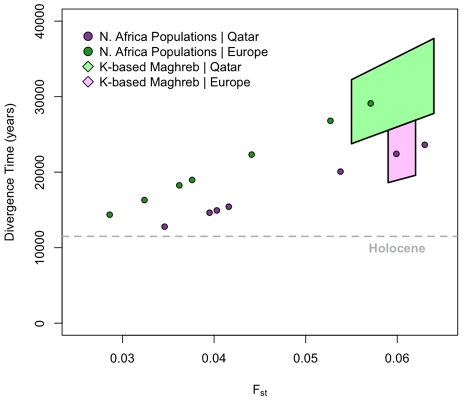
Divergence time estimates among European, Maghrebi, and Near Eastern ancestral populations.We use population-based Fst to estimate divergence time between each of the North African populations and the Qatari (green dots) and Tuscans (purple dots), respectively. We assume point estimates of effective population sizes based on autosomal haplotype heterozygosity estimates from Li et al. [17] (Material and Methods). We further estimate ancestral population clusters assigned at k = 5–8 with ADMIXTURE. Assuming that the ancestral clustering procedure has removed, or at least mitigated, the effect of recent migrations into Mediterranean populations, we then use Fst to estimate divergence times between these ancestral clusters. The range of k-based estimates for Maghrebi versus Near Eastern ancestry is indicated with light green polygon. The range of k-based estimates for Magrebi versus European ancestry is indicated with light purple polygon.